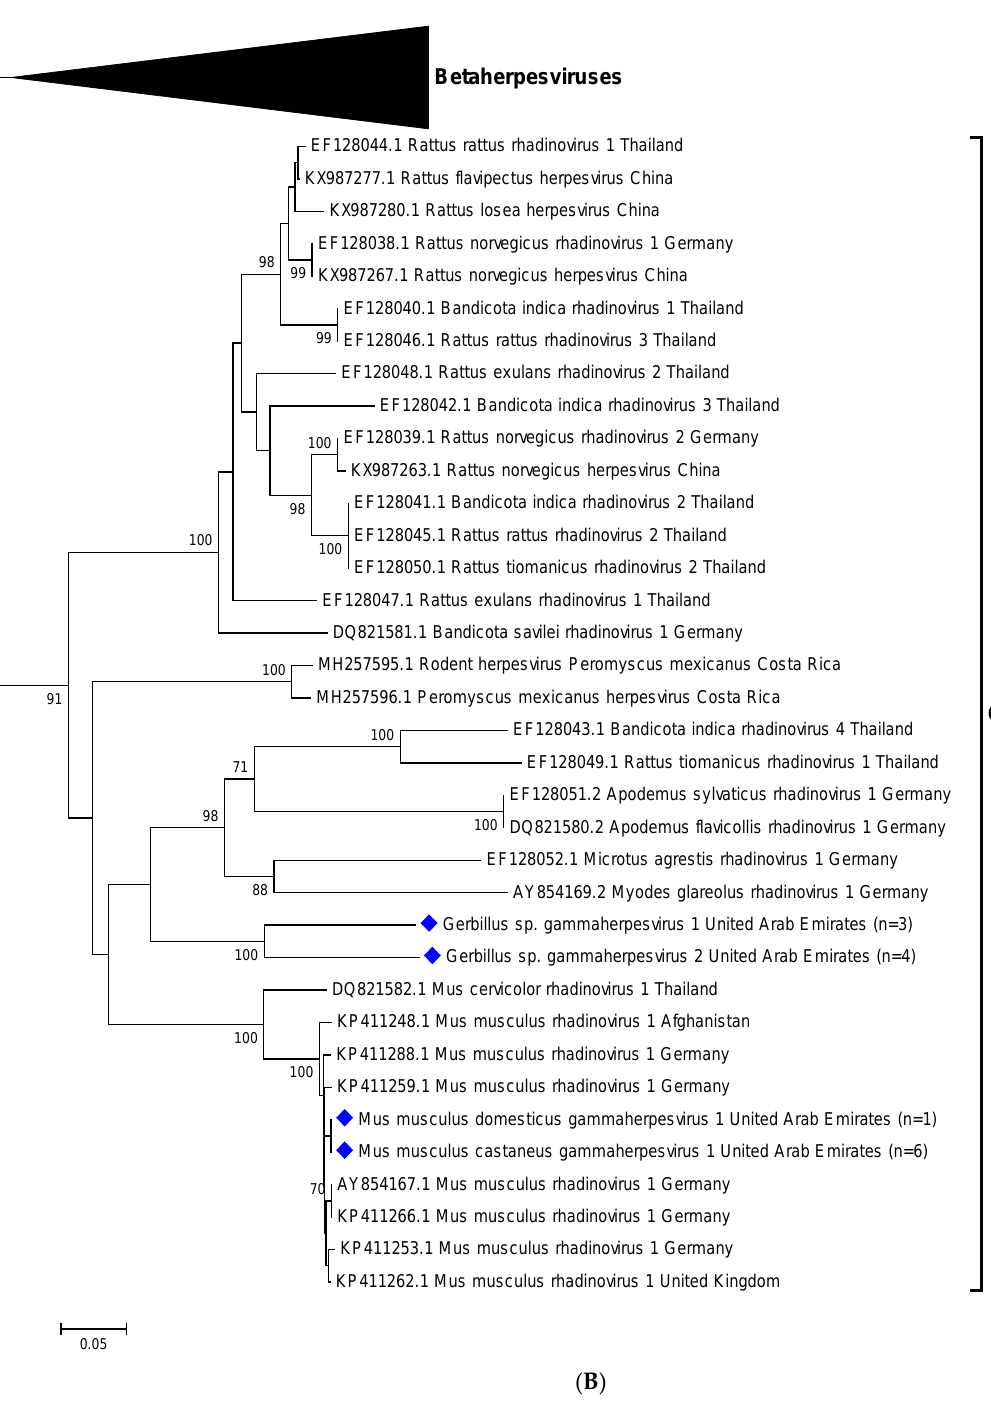
Figure 1. Phylogenetic tree of 74 partial beta- and gammaherpesviral DNA polymerase gene se- quences. For each sequence, the corresponding GenBank accession number (reference sequences), host species and country of origin are indicated. Horizontal lines represent the genetic distances according to the scale at the bottom. Bootstrap values ≥70% are displayed at the nodes. ( A ) Ex- panded view of partial betaherpesviral DNA polymerase gene sequences that were detected in 12 oro-pharyngeal swab and fecal samples from gerbils. A total of eight identical sequences were detected in Gerbillus sp. samples and clustered together between Rattus , Bandicota, and Apodemus cytomegalovirus sequences. This novel strain was designated Gerbillus sp. betaherpesvirus 1 . There were two identical sequences found in Gerbillus nanus samples that clustered next to this strain and were named Gerbillus nanus betaherpesvirus 1 . Another two identical sequences found in Gerbillus